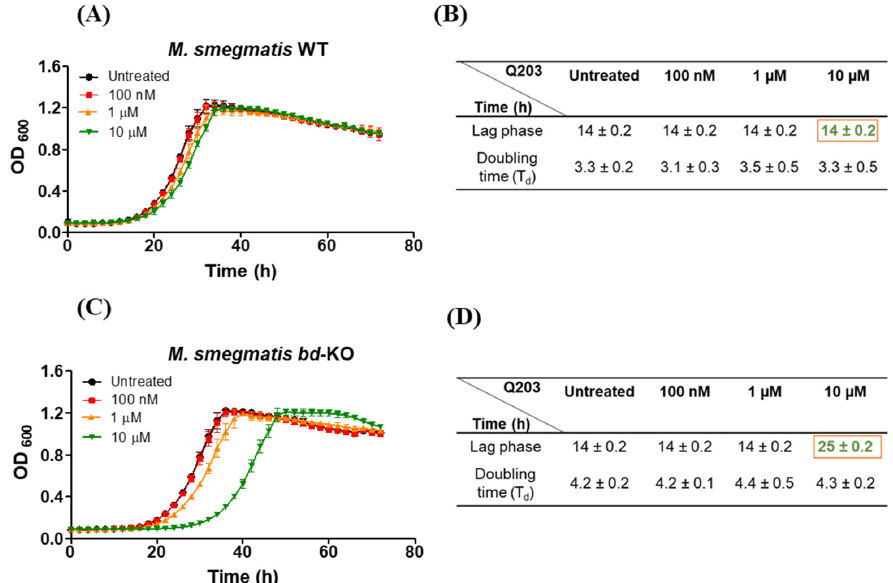
Figure 1. The effect of Q203 on the growth of M. smegmatis . Microplate reader-based growth analysis and growth parameters of ( A , B ) M. smegmatis wild-type (WT) and ( C , D ) M. smegmatis mutant strain with knocked-out cytochrome bd ( bd -KO) in the presence and absence of indicated Q203 concentrations. The extended lag-phase in presence of Q203 is indicated by a red frame. Mean ± SD of three independent cultures (biological replicates) are plotted.